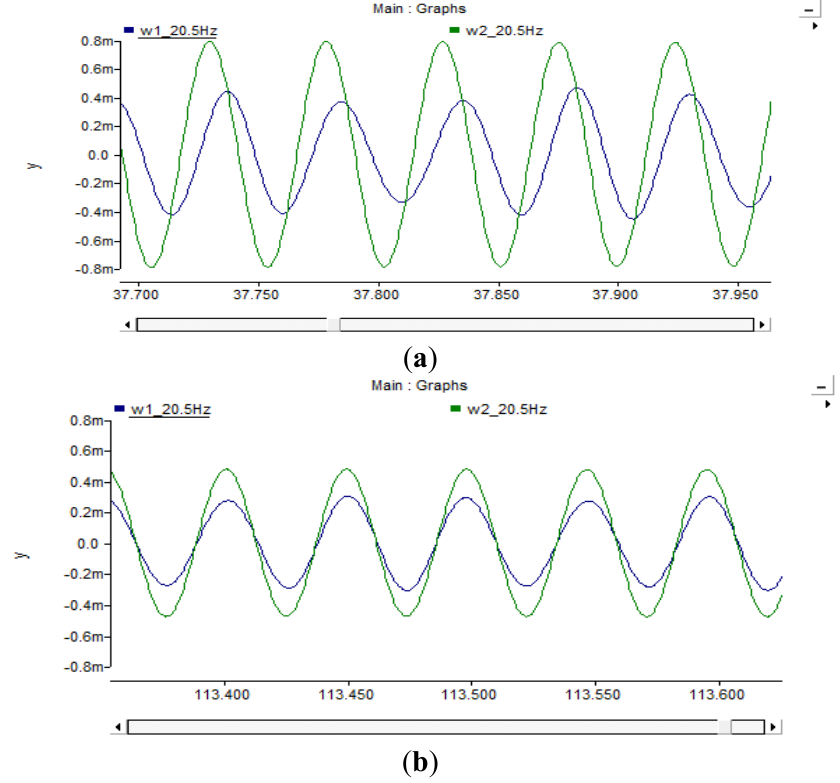
Figure 10. The 20.5 Hz components of the generator speed signals ( a ) at the start of the oscillation and ( b ) after some time.